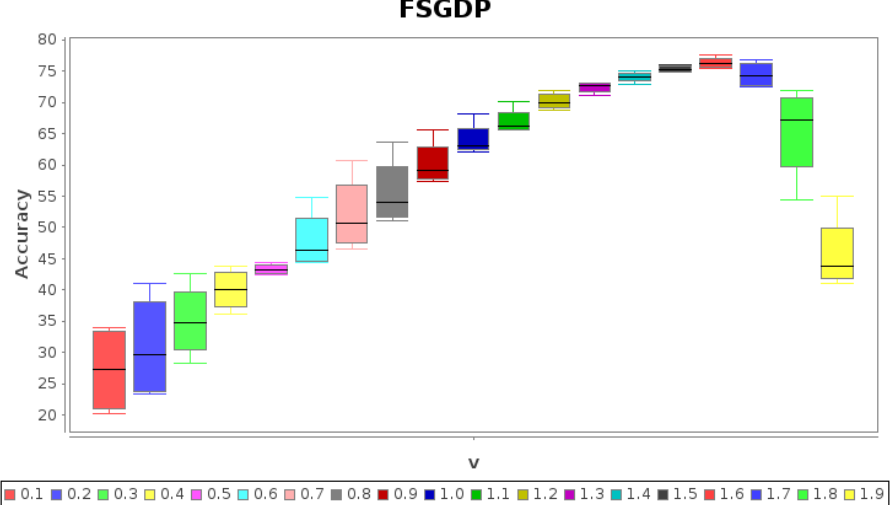
Figure 12. Experiment 3.1: FSGDP cross-folding accuracies, K = 4 folds, ν ∈ [ 0.1,1.9 ] .